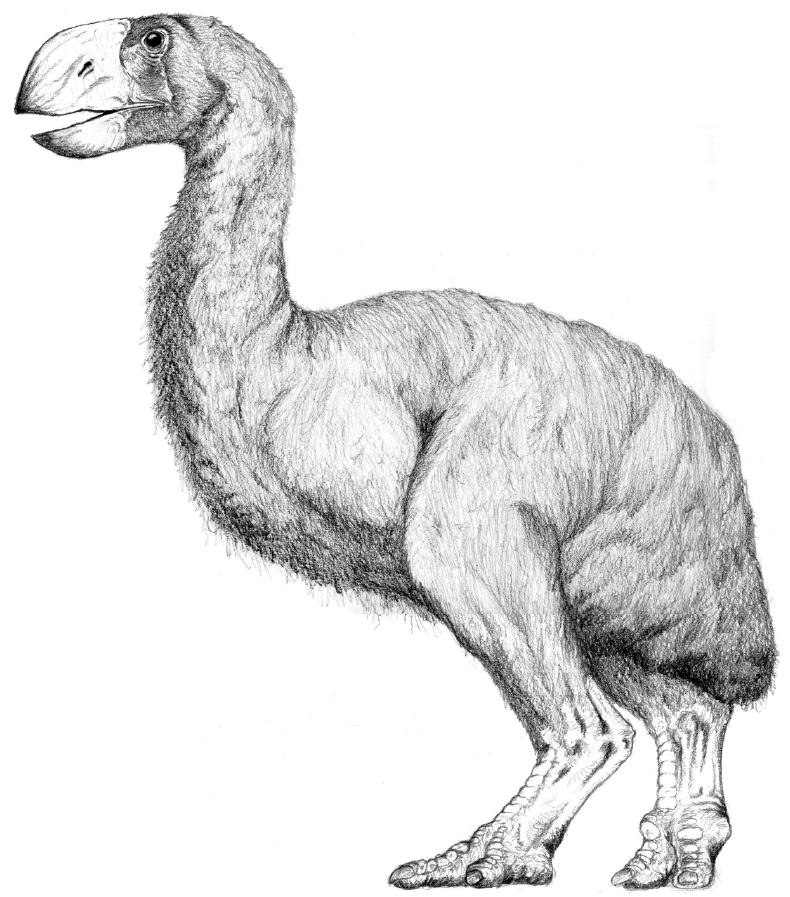
Figure 8. Life reconstruction of Brontornis burmeisteri . Artwork by Agustín Agnolin.